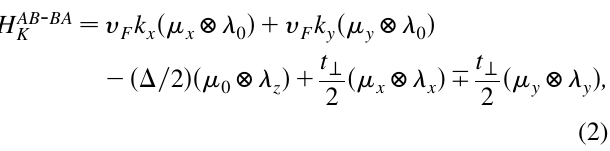
FIG. 3. (a) The energy bands of AB - BA bilayer graphene con- nected to the two domain walls depicted in Fig. 2. The Fermi level is indicated with the dashed blue line, and the bands with the marked linear dispersion relation intersecting near the Fermi level are outlined by the purple (light) curves. (b) Top and side views of point of (a). The the charge distribution for a state near the K 1 yellow rectangles indicate the AB - BA domain-wall